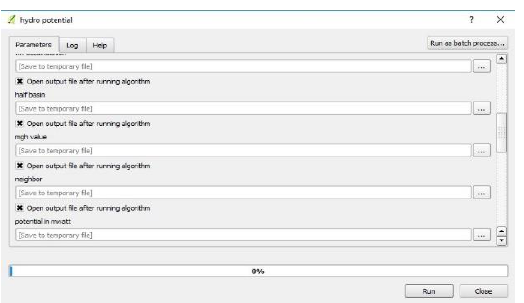
Figure 3(B).Graphical user interface of hydro potential model.